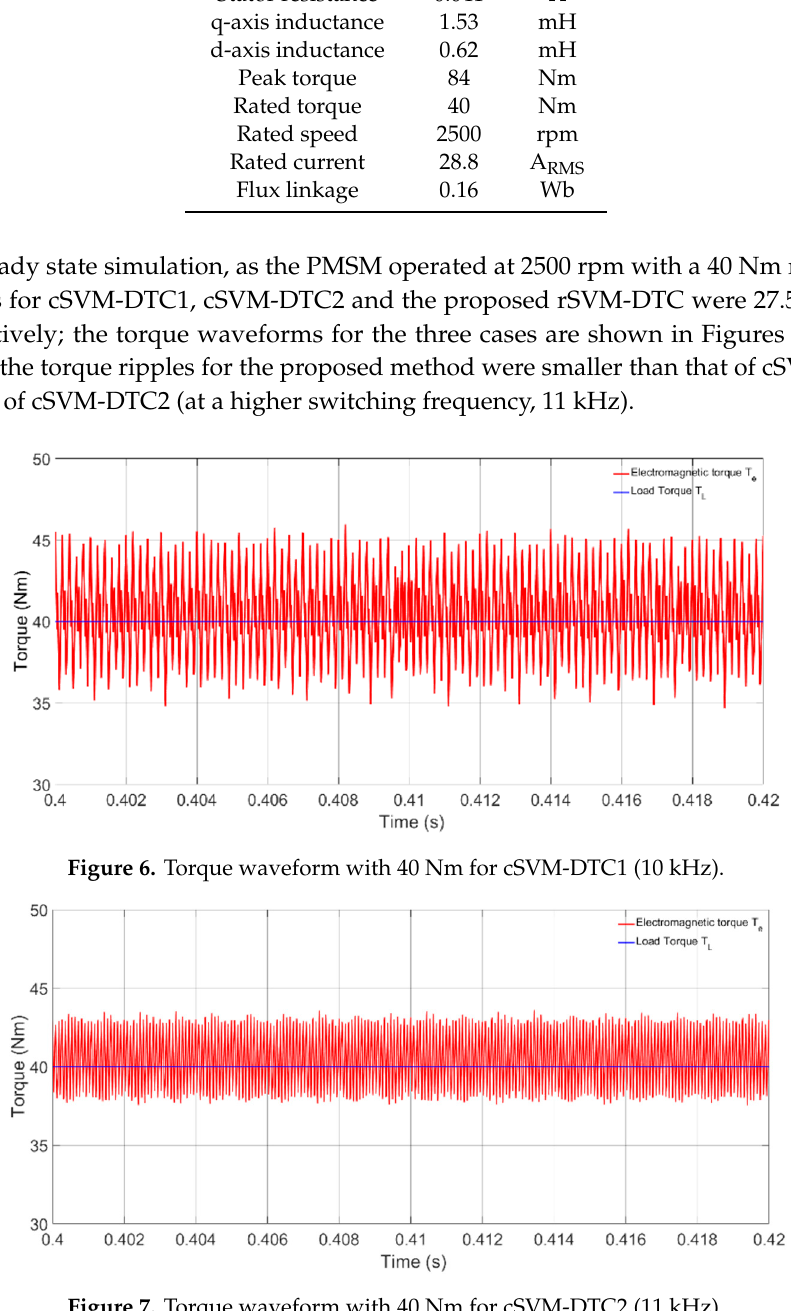
Figure 7. Torque waveform with 40 Nm for cSVM-DTC2 (11 kHz).